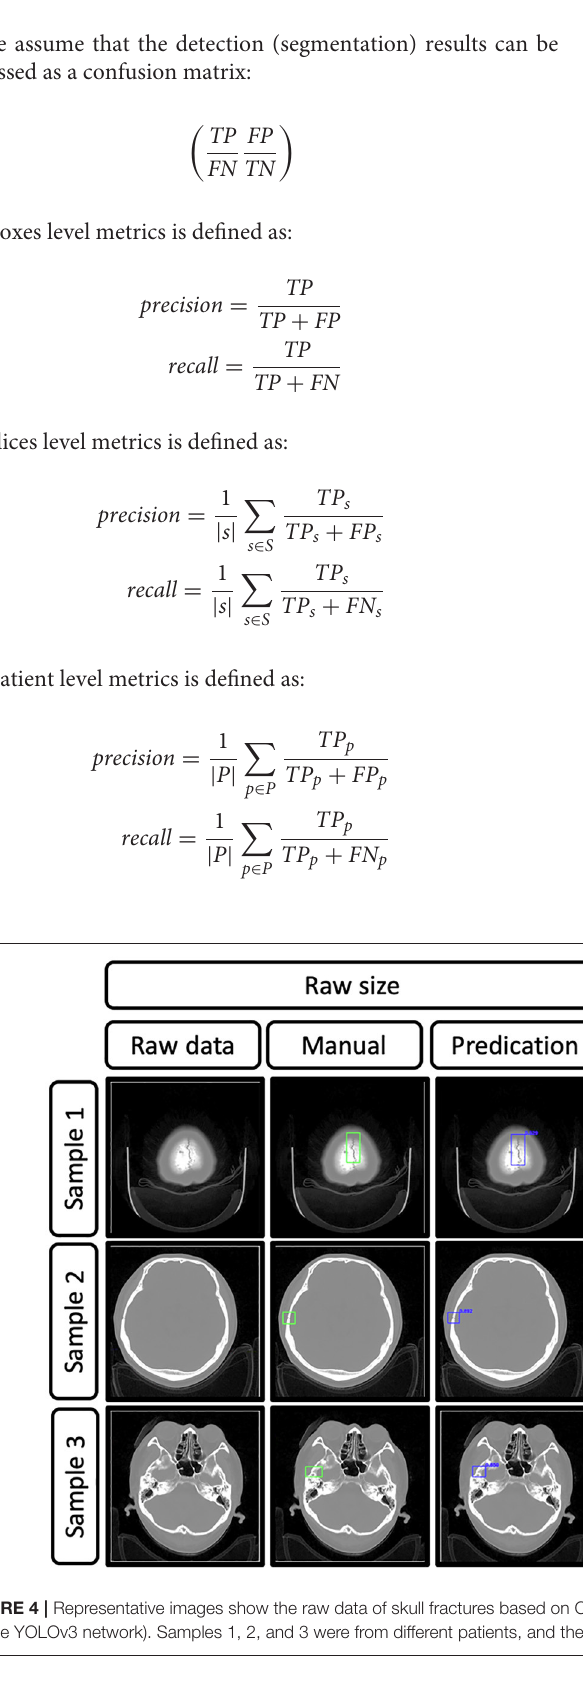
Frontiers in Neurology |